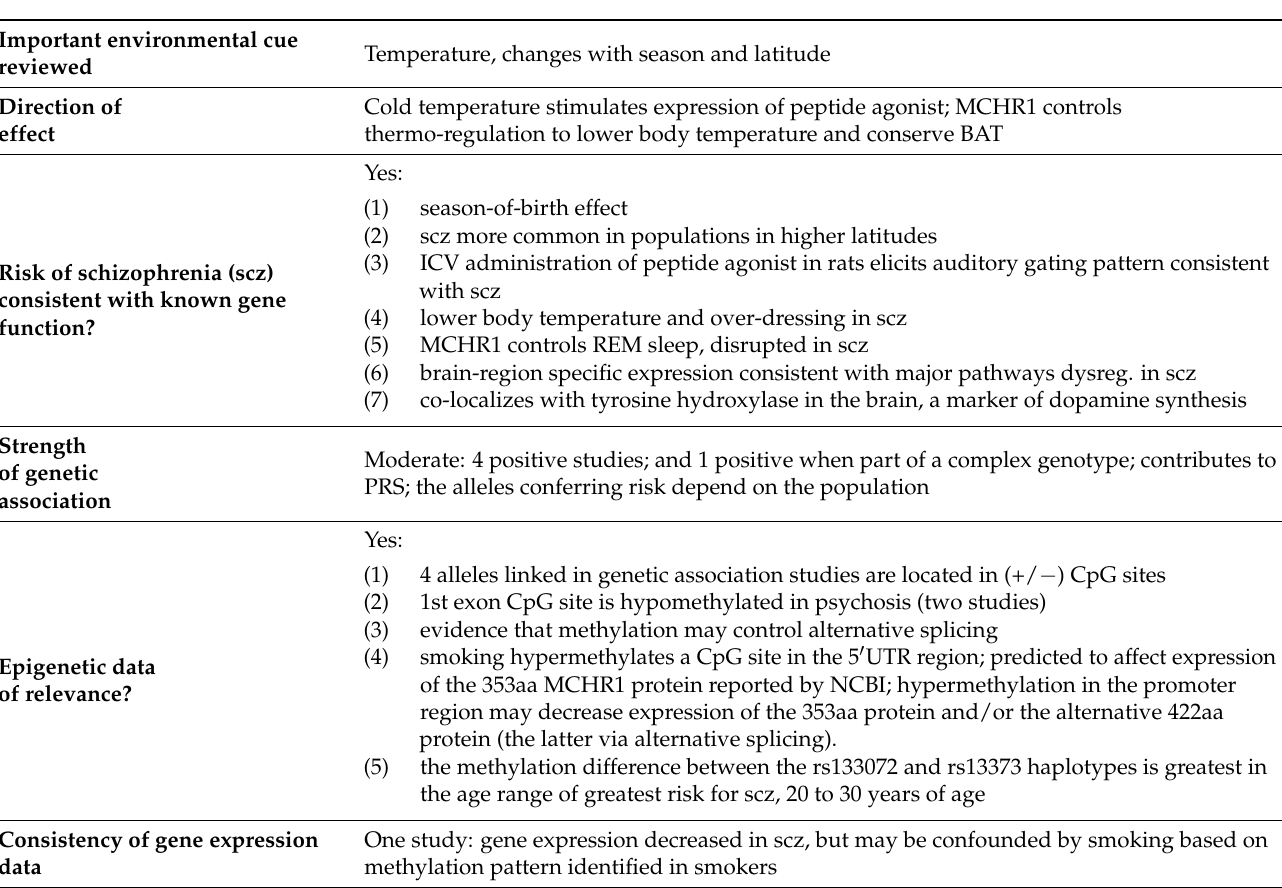
Table 1. Summary of major points for the gene